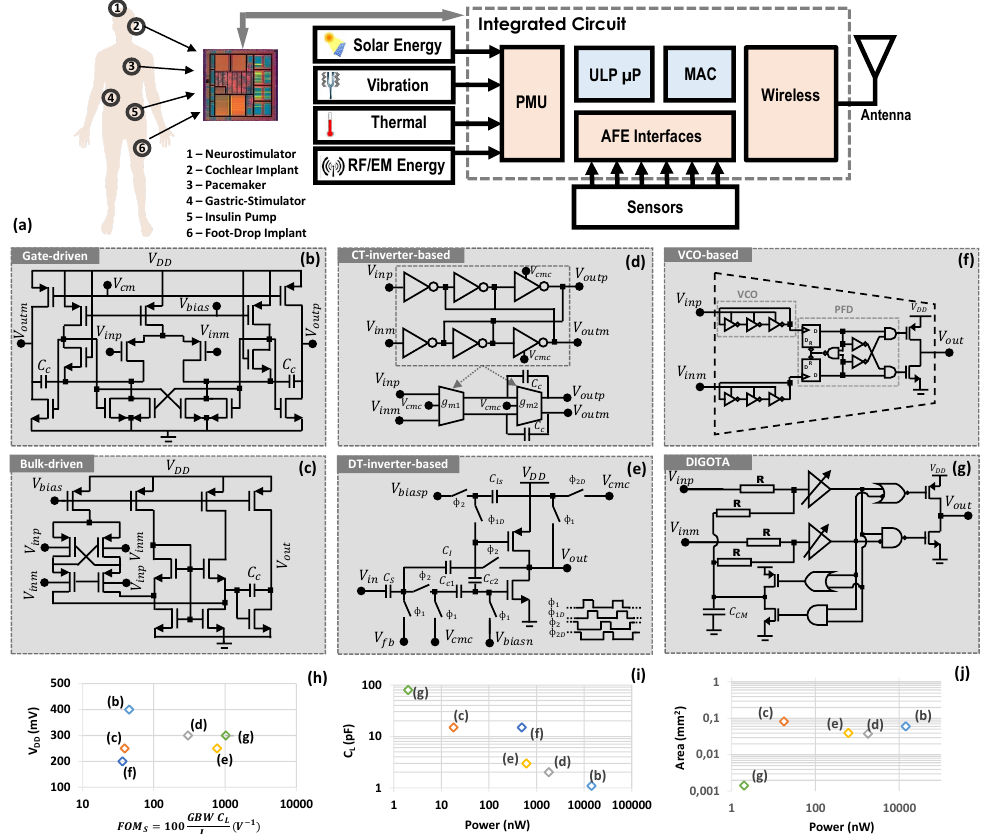
Figure 1. ( a ) General block diagram of an IoT energy-harvesting-enabled device, including its Power Management Unit (PMU), Analog Front-End (AFE) interfaces, ULP microprocessor ( µ P ), Media Access Control (MAC) unit, Wireless unit. ( b ) Gate-driven [8,9], ( c ) Bulk-driven [10] ( d , e ) Inverter-based [11,12] ( f ) VCO-based [13,14] ( g ) Digital-based [16] topologies. ULV OTA state-of-art comparison